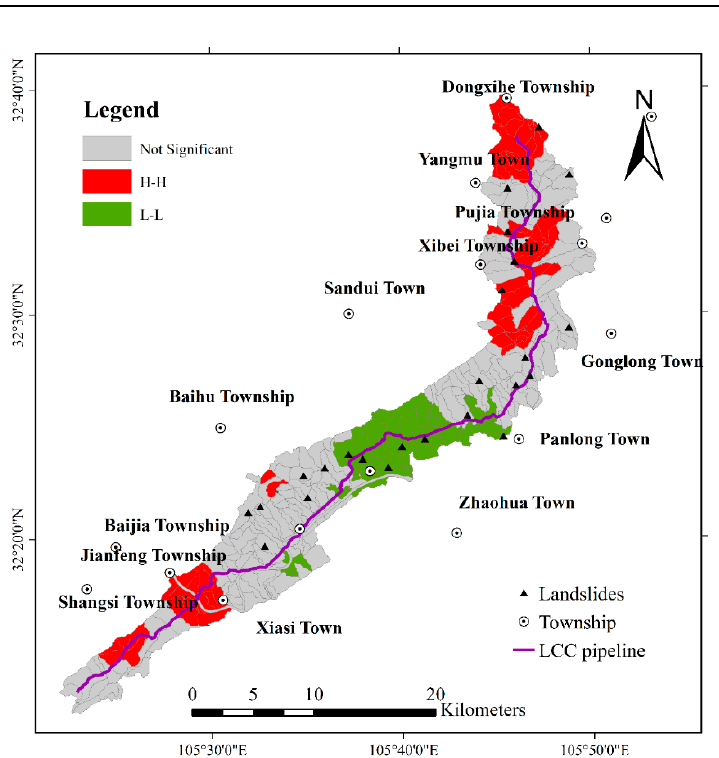
Figure 9. Spatial distribution pattern of local indicators of spatial association (LISAs) for the study area.